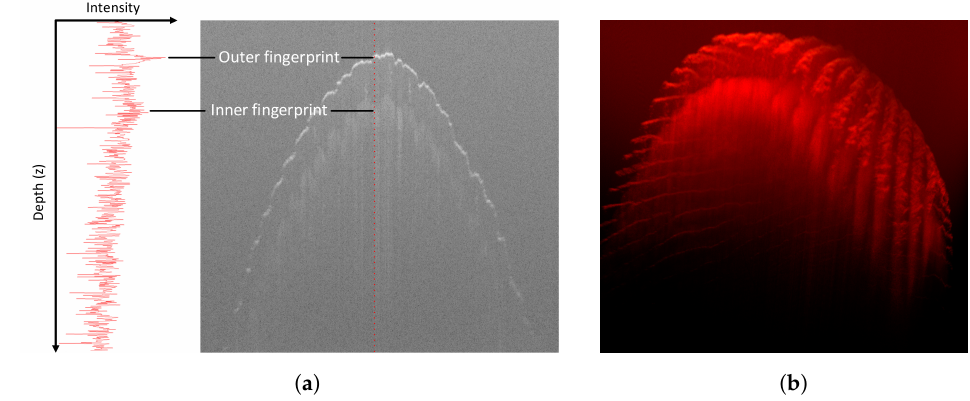
Figure 2. OCT scan data. ( a ) A-scan (left) and B-scan (right). ( b ) 3D scan rendered with